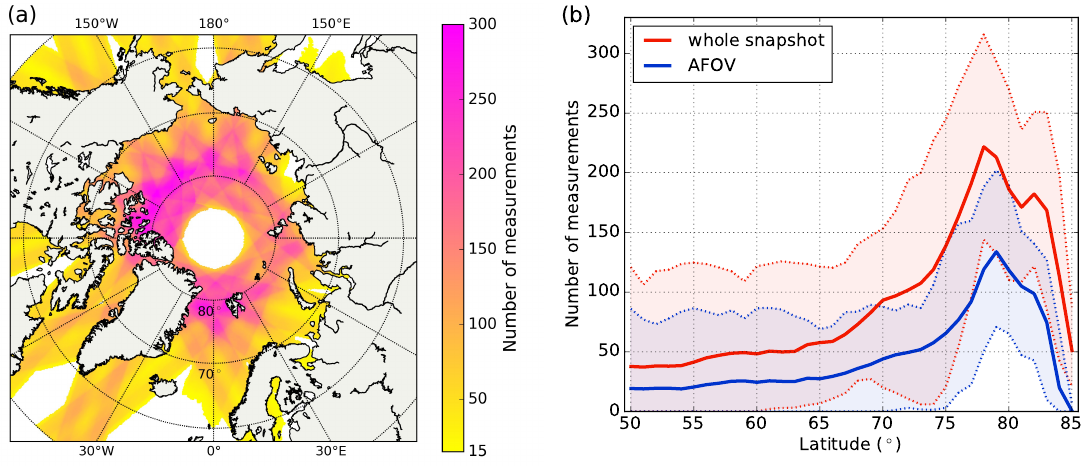
Figure 2. ( a ) geographical distribution of the number of SMOS measurements per day on 1 March 2016 for data from whole snapshots; ( b ) average number of SMOS measurements per day as a function of latitude for data from whole snapshots and from AFOV. Solid lines are averages and the shaded area marks the range of the